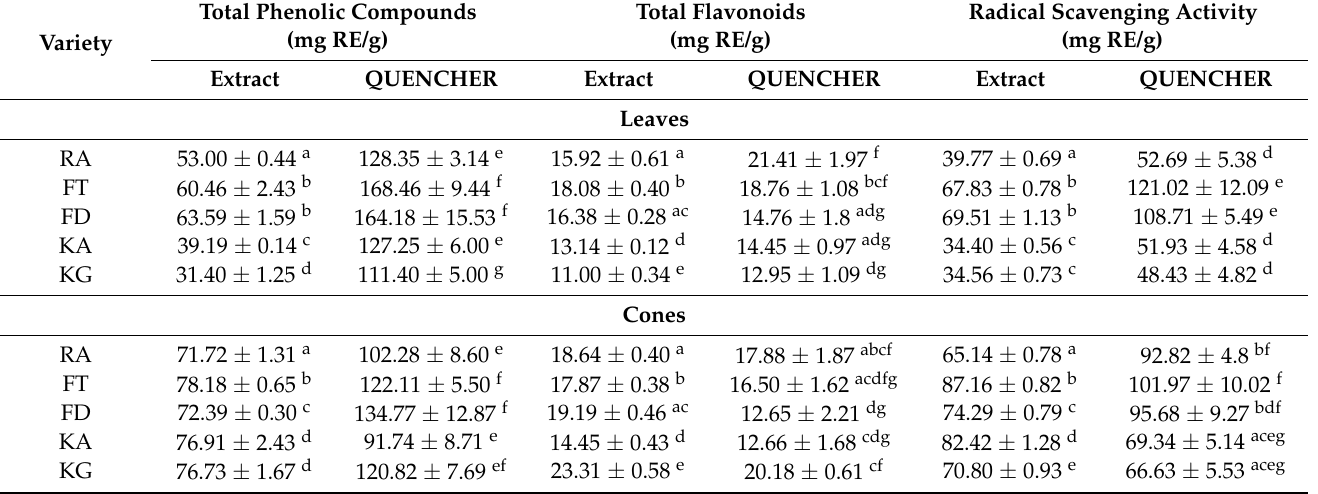
Table 1. The total content of phenolic compounds, flavonoids, and radical scavenging activity of leaves and cones of analyzed varieties using aqueous 75% methanol (75% (vol.)) extraction and QUENCHER procedure ( n =